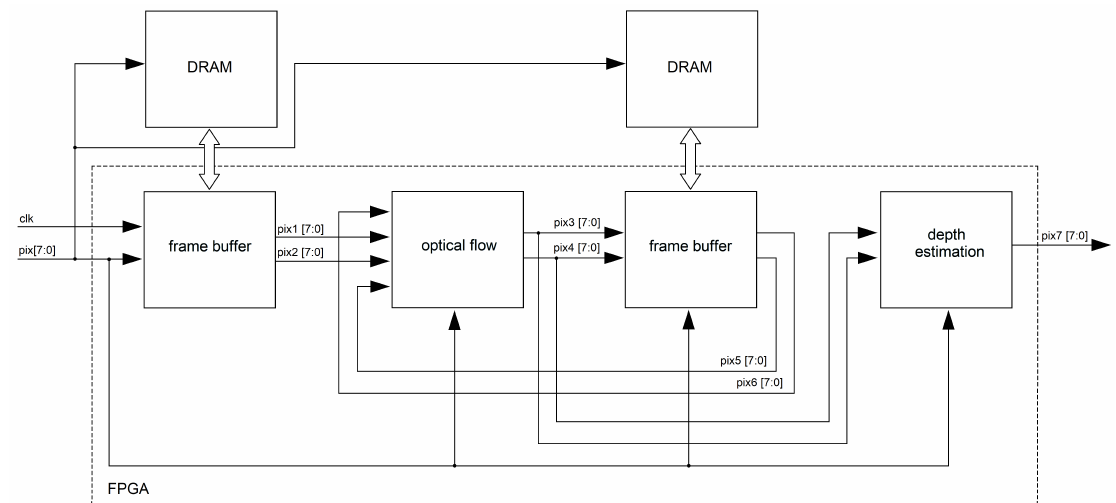
Figure 8. FPGA architecture for the proposed